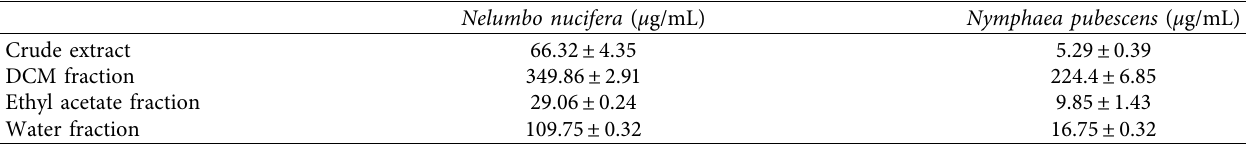
Table 3: IC 50 values of in vitro α -glucosidase inhibition of Nelumbo nucifera and Nymphaea pubescens